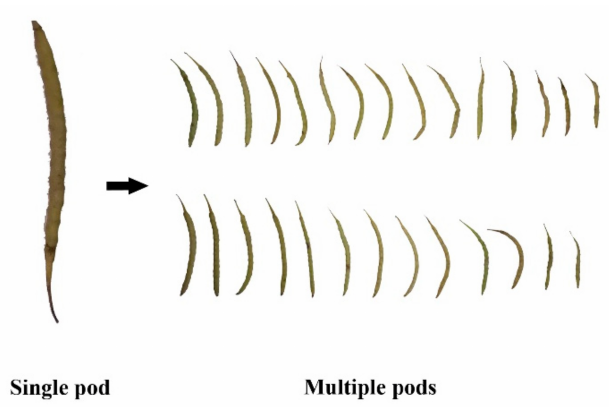
Figure 1. Two dimensions of the surface area measurement of rapeseed